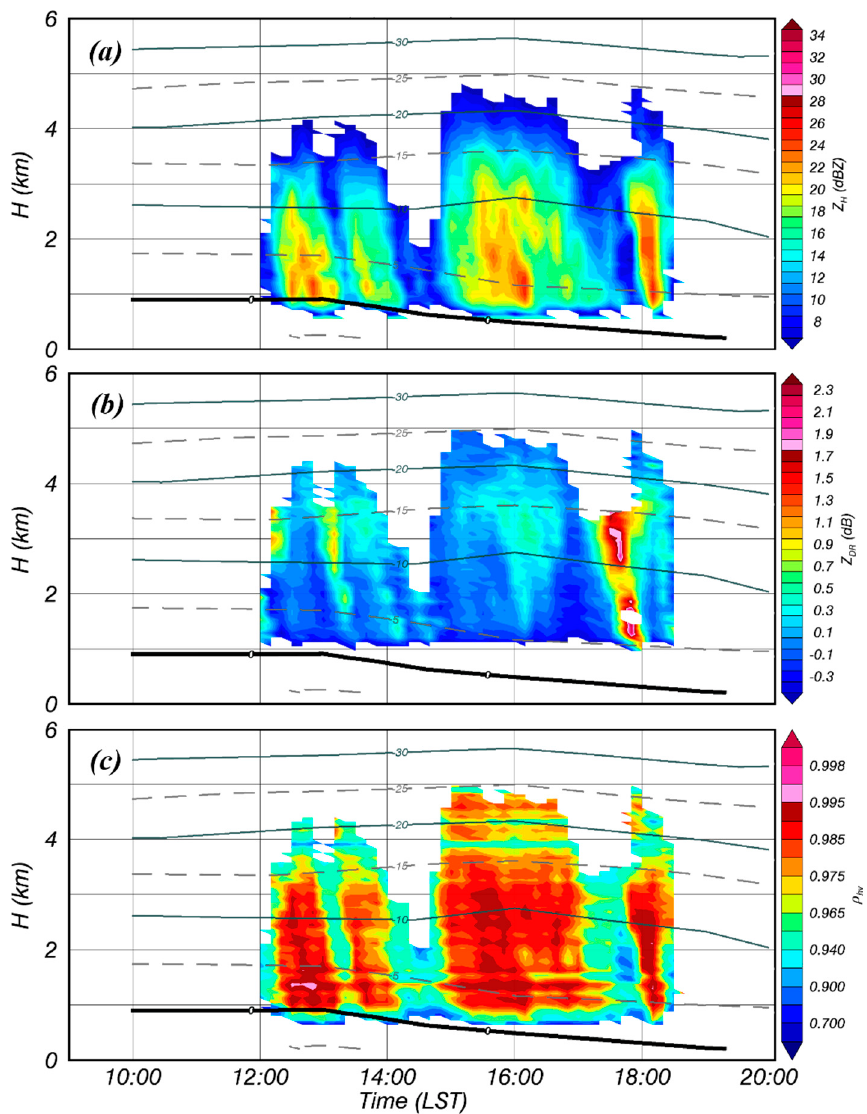
Figure 11. Time series of the QVP of the dual-pol radar variables for C2 (28 February 2016): ( a ) Z, ( b ) Z DR , and ( c ) ρ HV . The lines in the background of the figure are the vertical temperature profiles obtained using the MSM reanalysis data.